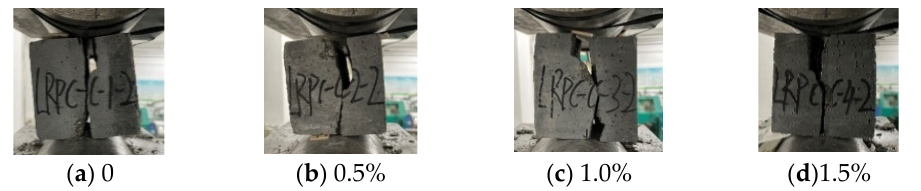
Figure 15. Splitting tensile failure modes of cubic specimens with di ff erent fi ber contents at − 15 °C.